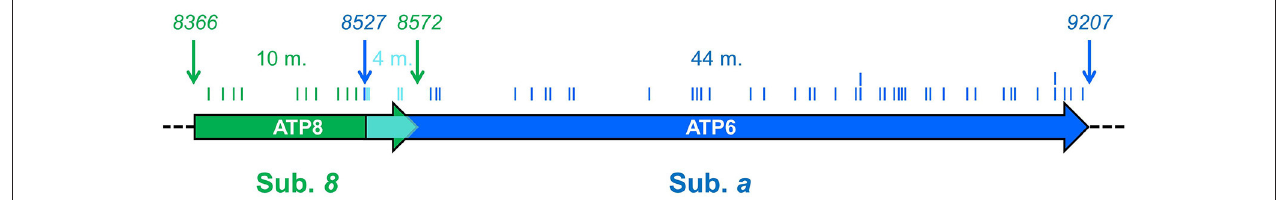
FIGURE 2 | ATP6 and ATP8 genes and sites of pathogenic mutations. The two coding sequences overlap, between positions 8527 and 8572 (cyan) of the human mitochondrial genome. Start and end nucleotide numbers are indicated. The number of mutations (m) identified in patients and their positions are indicated. These mutations are listed in Table 2